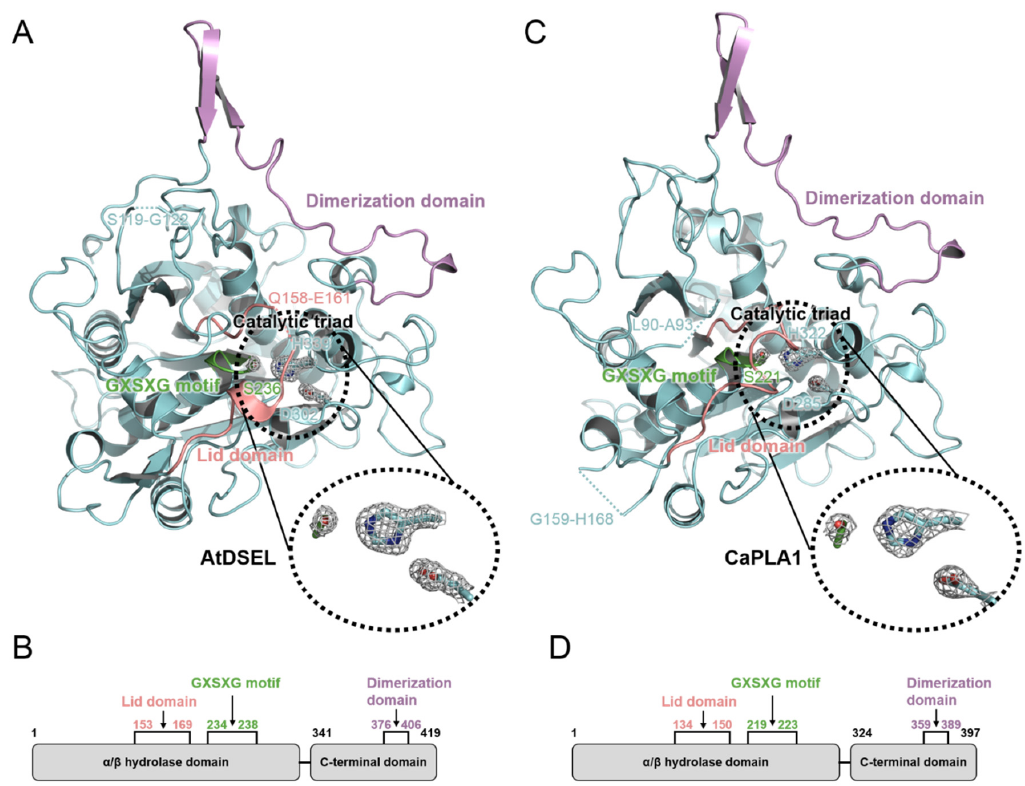
Figure 2. Conserved catalytic triad and domains of AtDSEL and CaPLA1. ( A ) Three residues (Ser236, Asp302, and His339) that compose the catalytic triad of AtDSEL are shown as a stick model. 2mF O − DF C electron density map at a level of 2.0 σ is superimposed to the residues. Lid domain is colored in salmon. Pro159 and Leu160 of the lid domain were disordered, causing the disconnected lid domain in this figure. Conserved GXSXG motif is colored in green, and dimerization domain is colored in purple. ( B ) The construct map of AtDSEL. The lid domain and GXSXG motif belong to α / β hydrolase domain. C-terminal domain containing dimerization domain exists only in plant phospholipase A1 (PLA1). ( C ) Three residues (Ser221, Asp285, and His322), which compose the catalytic triad of CaPLA1, are shown as a stick model. 2mF O − DF C electron density map at a level of